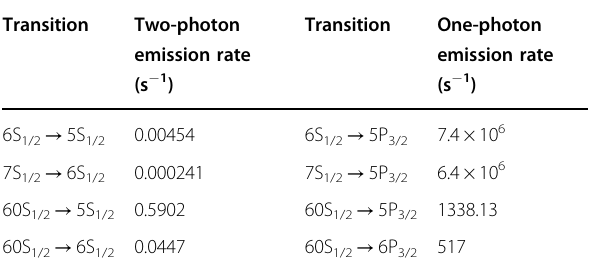
Table 1 Two-photon emission (TPE) rates for a rubidium atom in free space.